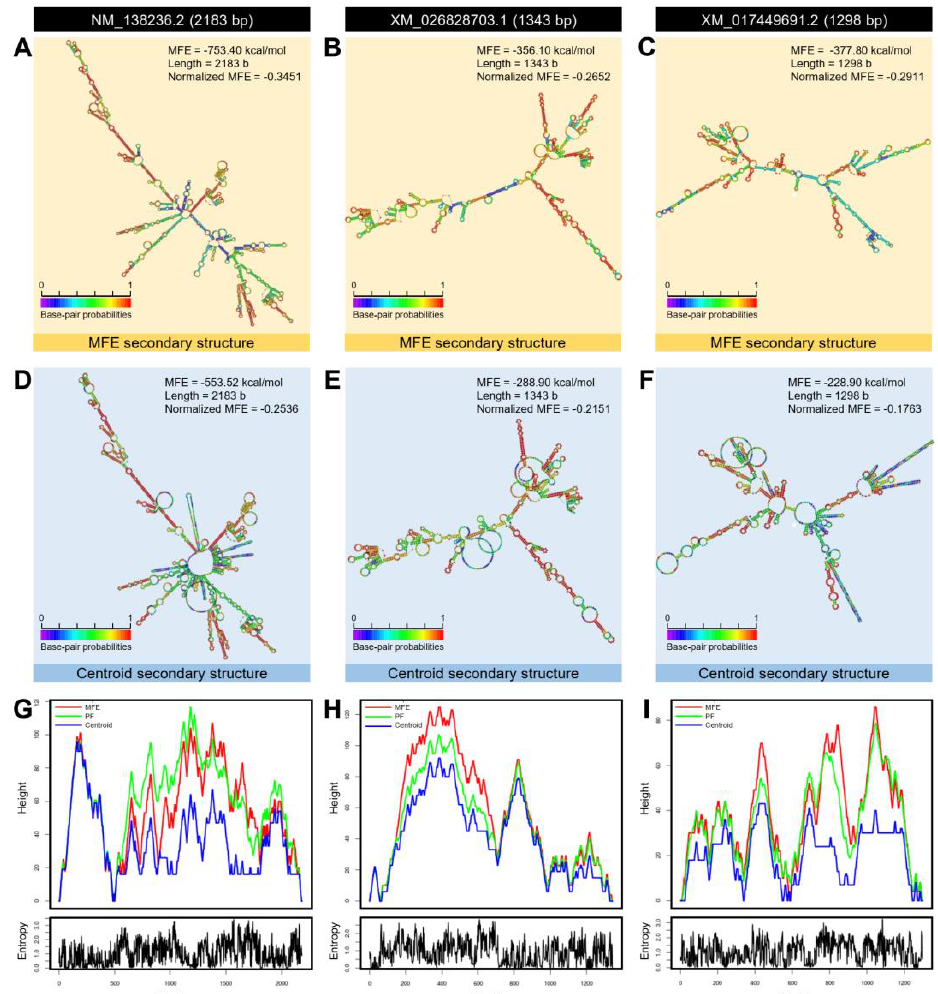
Figure 3. mRNA hairpins of tryptophan 5-hydroxylase ( DcT5H ) of Diaphorina citri . ( A – C ) Predicted minimum free energy (MFE) secondary structure of DmT5H (NM_138236.2), DcT5H -1 (XM_026828703.1), and DcT5H -2 (XM_017449691.2), respectively. ( D – F ) Predicted centroid second- ary structure of DmT5H , DcT5H -1, and DcT5H -2, respectively. Colors represent strengths with base-pairing probabilities. ( G – I ) The mountain plot representations of the MFE structure, the cen- troid structure, the thermodynamic ensemble of mRNA structures, and the positional entropy of DmT5H , DcT5H -1, and DcT5H -2, respectively. mRNA secondary structures were predicted using